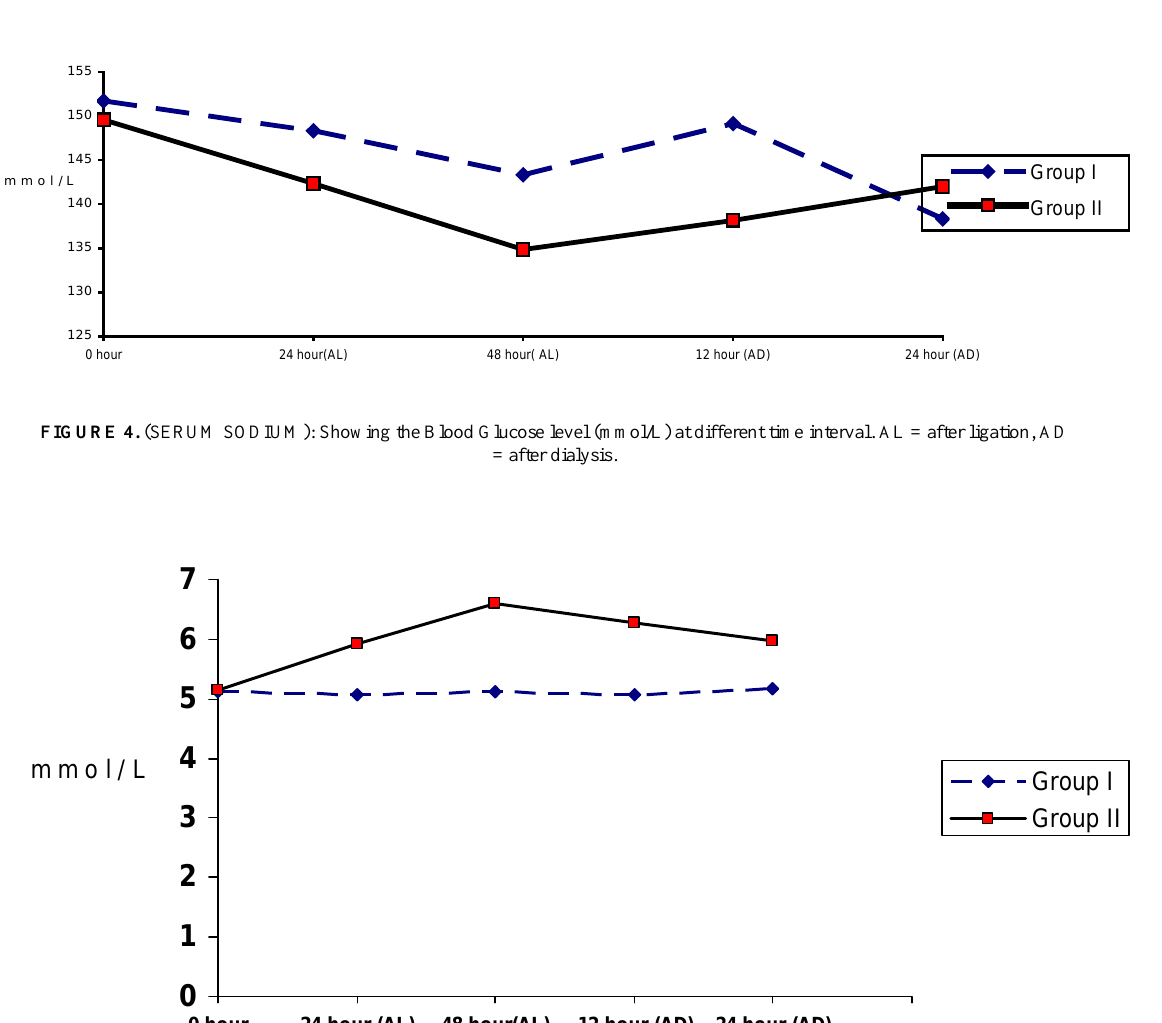
The fall in blood glucose 24 and 48 h after ureteric ligation might be due to continuous anorexia and utilization of reserve stores during starvation. Subsequent rise of blood glucose were due to absorption of glucose from dialysate (Table 2 and Fig.